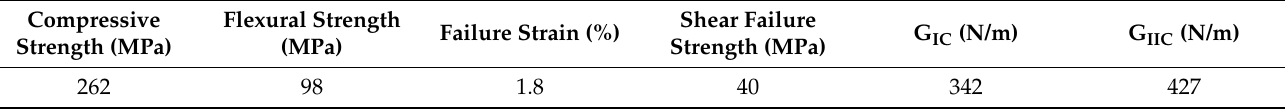
Table 2. Mechanical properties of the resin cement adhesive [31,32].